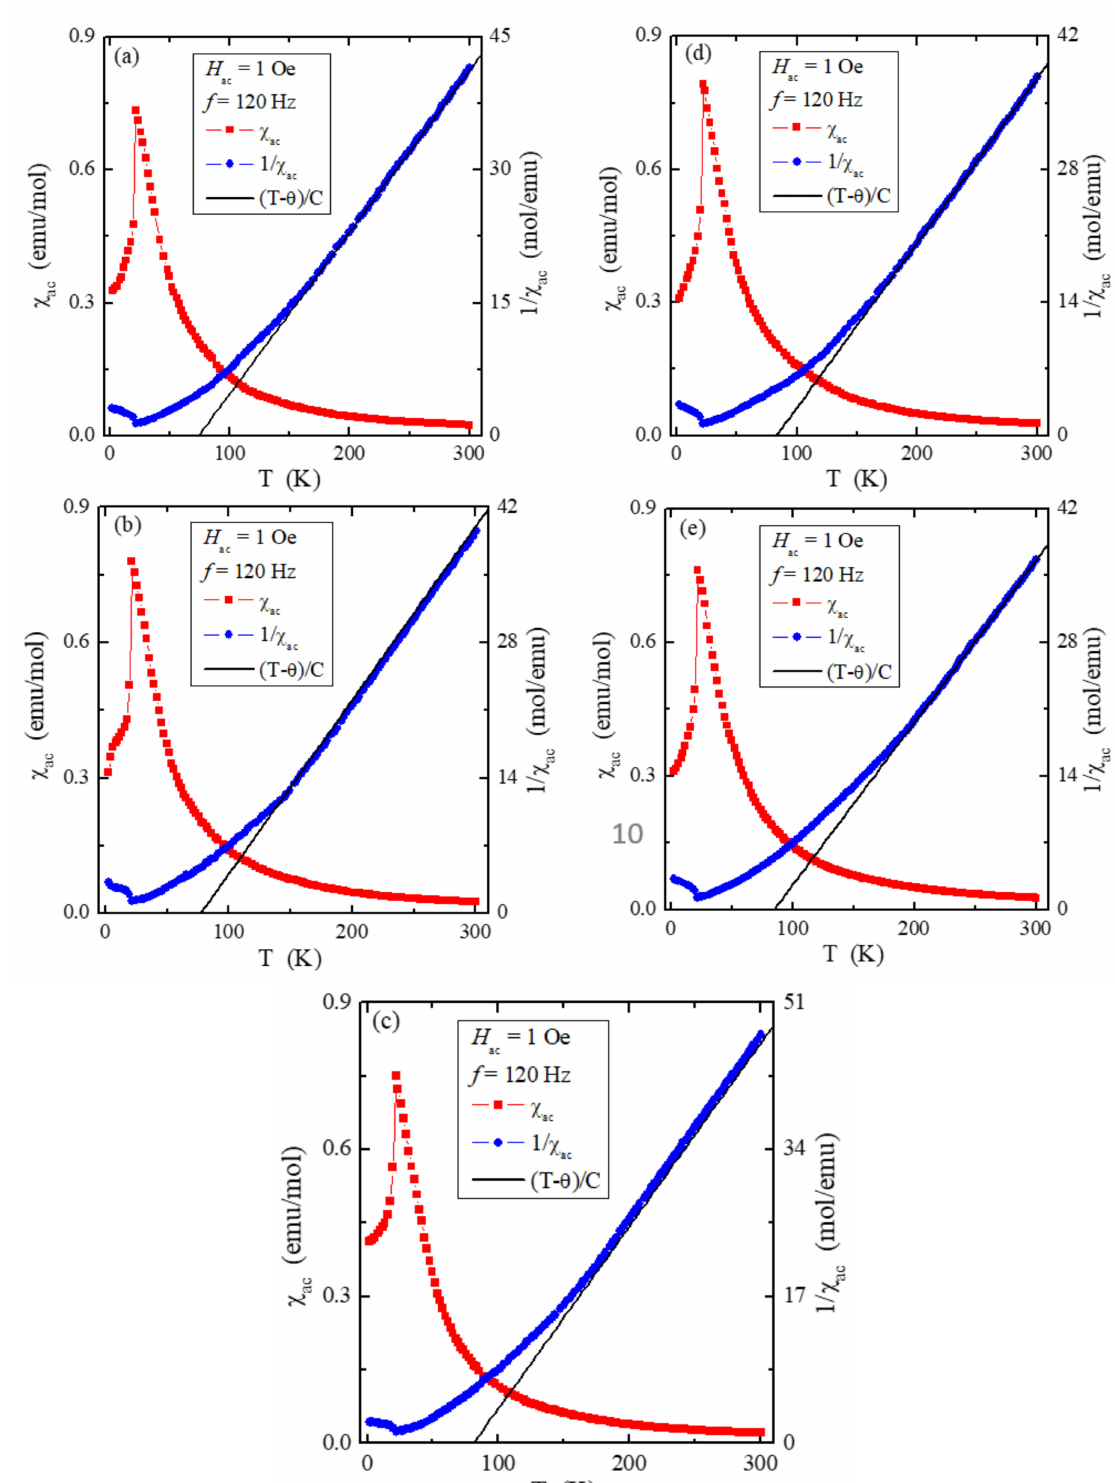
Figure 7. Ac magnetic susceptibility χ ac and its reciprocal 1/ χ ac vs. temperature T recorded at internal oscillating magnetic field H ac = 1 Oe with internal frequency f = 120 Hz for the ZnCr 2 Se 4 single crystals doped with Pb 2+ ions having contents of 0.06 ( a ), 0.07 ( b ), 0.09 ( c ), 0.11 ( d ), and 0.12 ( e ). The solid (black) line, (T– θ )/C , indicates a Curie–Weiss